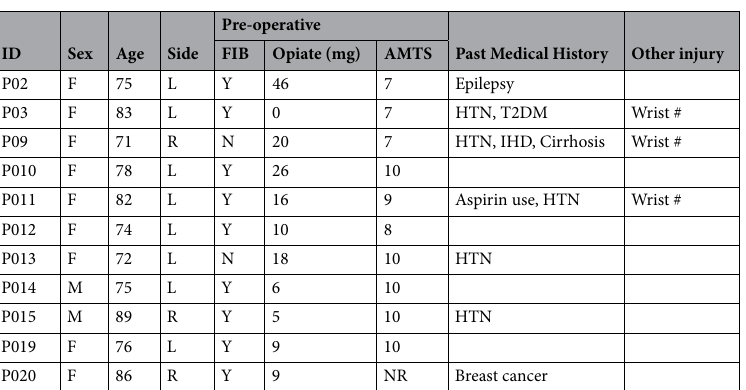
Table 1. Participant’s background and treatment prior to surgery. A table showing the medical backgrounds and pre-operative management for the 11 patients included in this study. AMTS = Abbreviated Mental Test Score, IHD = Ischaemic heart disease, FIB = Fascia Iliaca block, HTN = Hypertension, NR = Not recorded, T2DM = Type 2 Diabetes, L = Left, R = Right, # = Fracture.